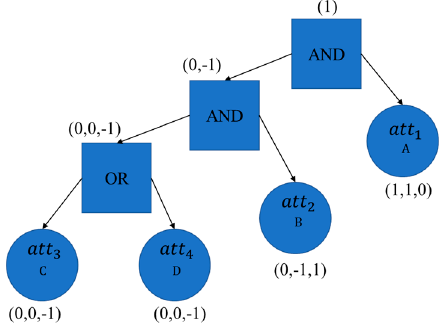
Figure 10. Access policy BF 1 of Sensor 1 .